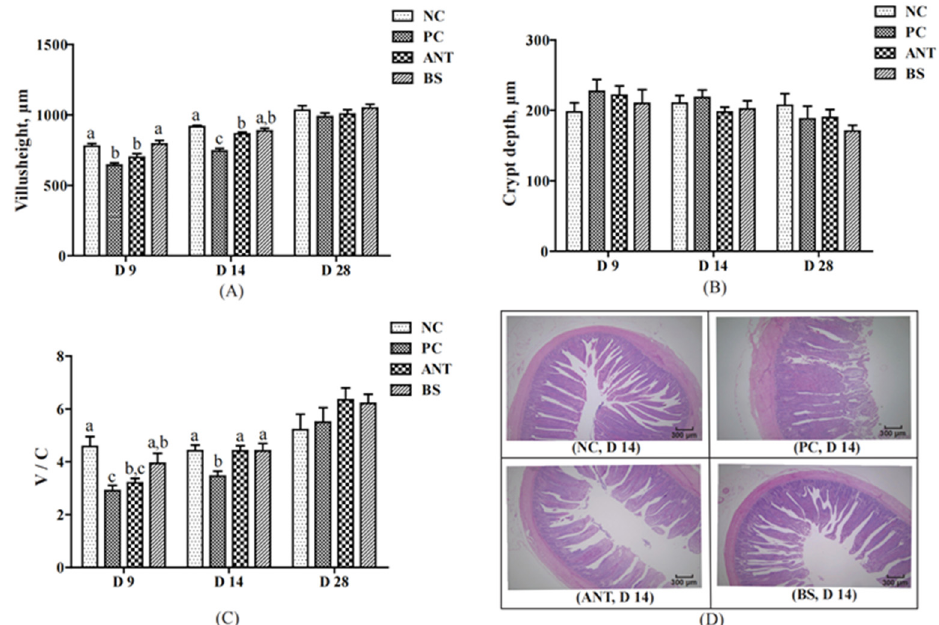
Figure 4. Effect of B. subtilis on jejunum histomorphology of ducks challenged with E. coli . NC– negative group, basal diet without E. coli challenge. PC–positive group, basal diet with E. coli chal- lenge. ANT–antibiotic group, basal diet + virginiamycin (30 mg/kg) with E. coli challenge. BS–basal diet + 2.5 × 10 9 CFU/kg B. subtilis with E. coli challenge. Data are indicated as means ± SEM. The individual duck in each replicate was the experimental unit ( n = 6). ( A ) The villus height in jejunal of ducks. ( B ) The crypt depth in jejunal of ducks. ( C ) The ratio of villus height to crypt depth in jejunal of ducks. ( D ) Histological damage in jejunal of ducks on day 14. a,b,c Values, for the same parameter and day, with different superscripts are significantly different ( p < 0.05).